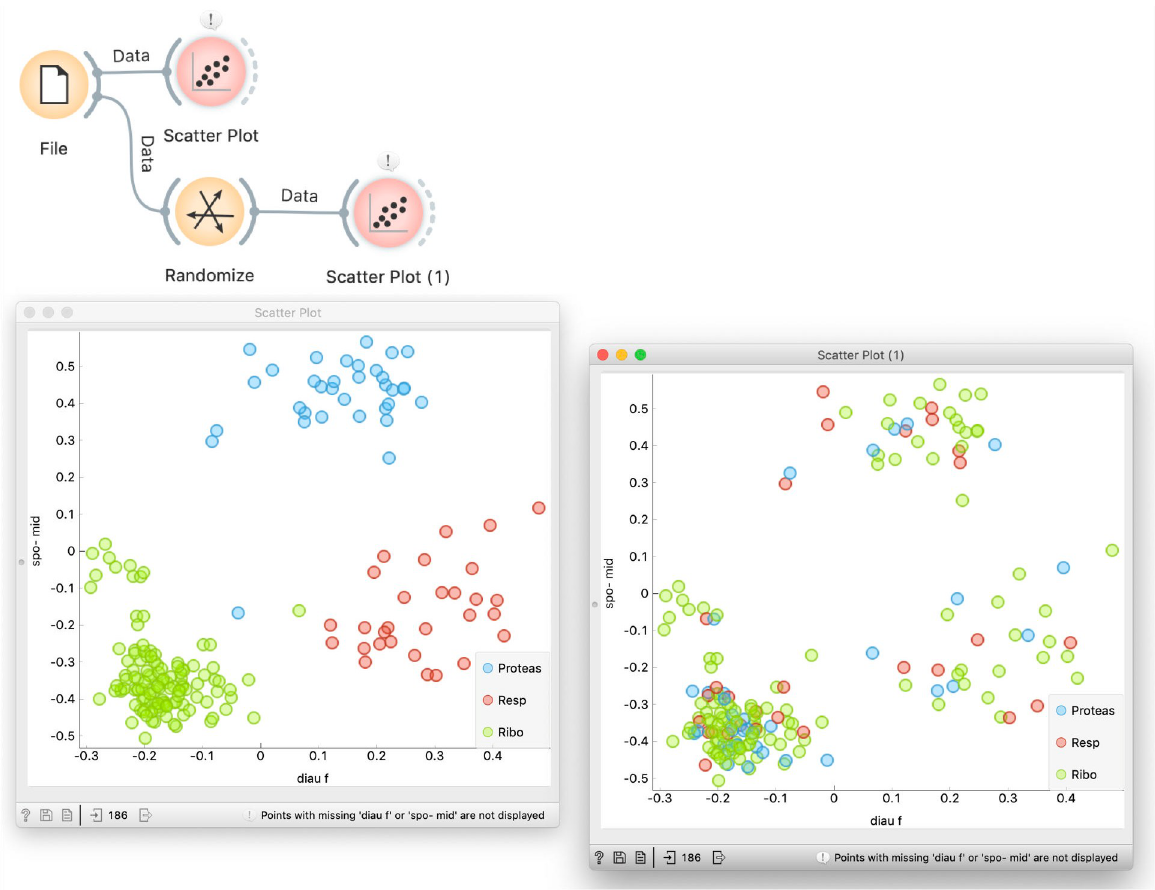
Fig 14. Exploring class-randomized data. Scatterplot in Orange can search for feature combinations that best split the classes. For the yeast expression data, diauxic shift ( diau f ) and sporulation at a five-hour timepoint ( spo-mid ) provide for the best combination. When the data is class- randomized, the class labels change, the pattern of class-separation is no longer there, but the data points keep their position. The effect of randomization is also visible by comparing the two Data Tables.